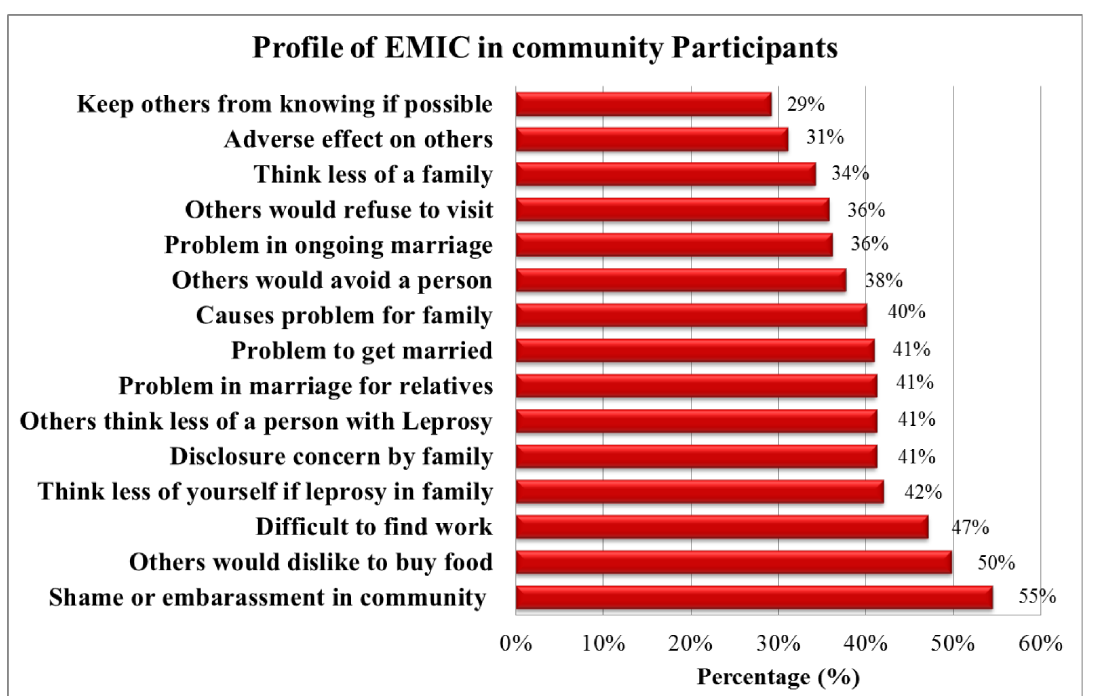
Fig 1. EMIC items of community participants answering “ Yes ” in